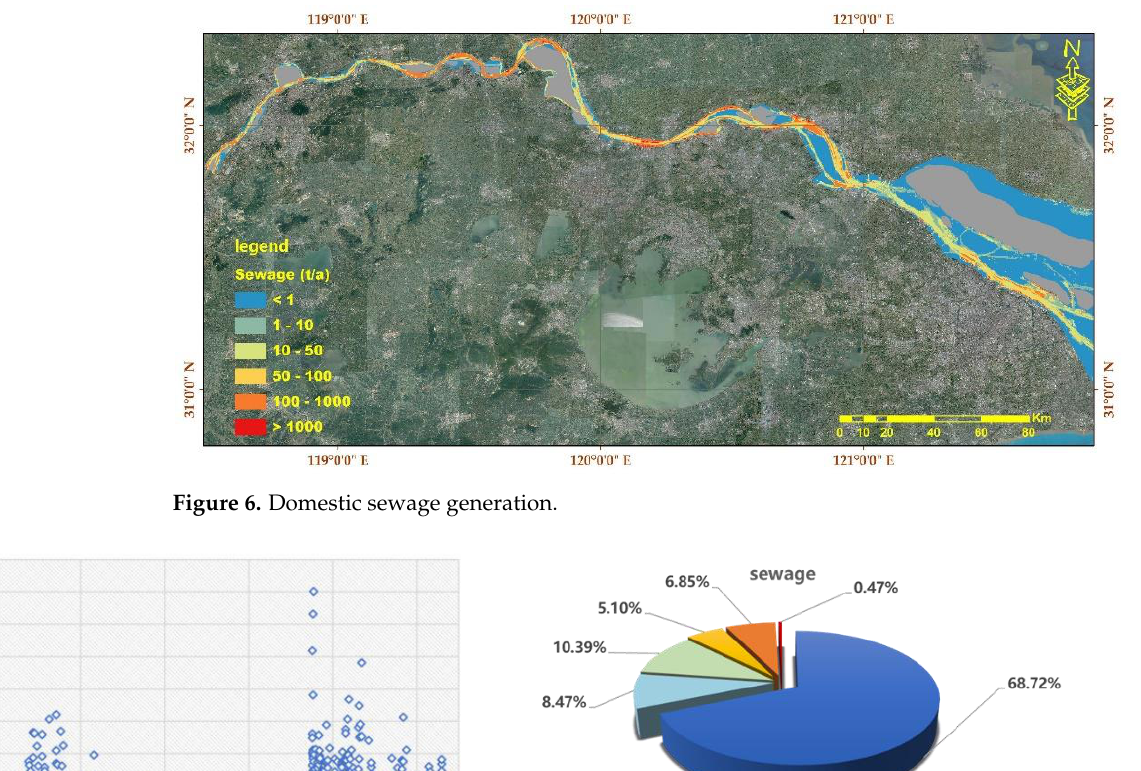
Table 2. Generation of ship water pollutants in the lower reaches of the Yangtze River (t/a).